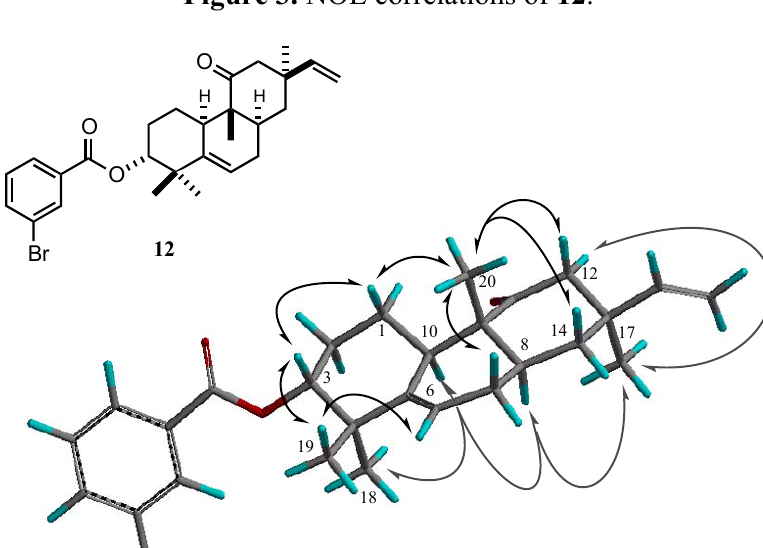
Figure 3. NOE correlations of 12